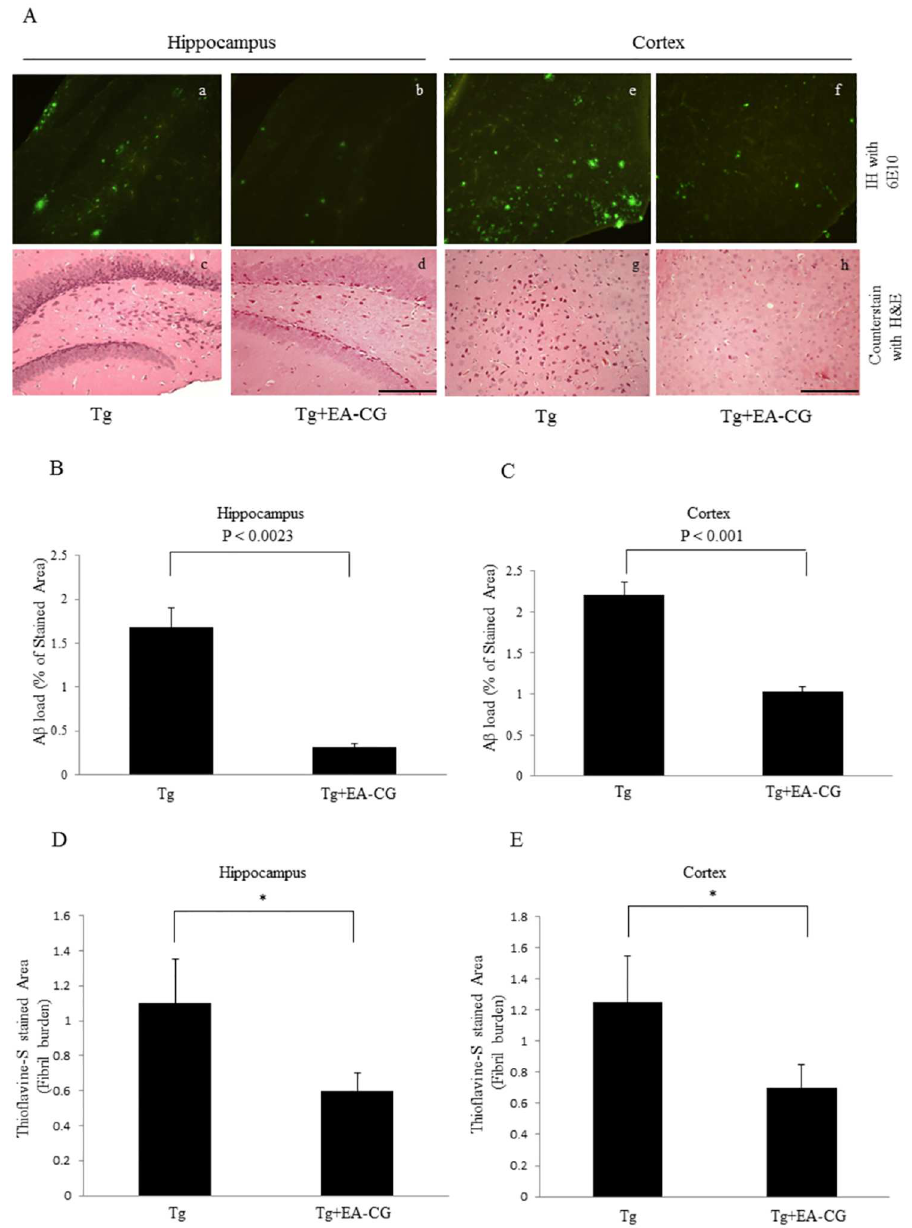
Fig 5. Comparison of the amyloid burden in the Tg brains by the CG extracts. (A) The amyloidplaques were identifiedby immunohistochemistry (IH) and H&E counterstaining. The CG extract-treated (EA-CG fraction) and control Tg brain sections were formalin fixed and subjectedto immunohistochemistry with the 6E10 antibody that interacts with the A β 1–16epitope(monoclonal antibody)in the hippocampus (a, control; b, EA-CG treated) and cortex (e, control; f, EA-CG-treated). Concomitant with the IH staining,other hippocampal (n = 6) (c, vehicle; d, EA-CG-treated) and cortical (n = 6) (g, vehicle; h, EA-CG-treated) sections from the Mo/Hu APPswe PS1dE9 mice were subjectedto H&E counterstaining. The scale bar indicates 200 μ m (a through h). The amyloidload (% of stainedarea) as a quantitationresult was decreasedby the CG extracts (B. hippocampus area; C. cortex area). The area in the hippocampus (D, vehiclealone vs. EA-CG) and cortex (E, vehiclealone vs. EA-CG) was quantified by comparing the morphometric analysisof the Thioflavin-S-stainedarea betweenthe vehicle-treated vs. EA-CG-treated Mo/Hu APPswe PS1dE9 brain sections. The values (%) shownwere the means ± S.E.M. * p < 0.05, Tg vs. Tg+EA-CG.